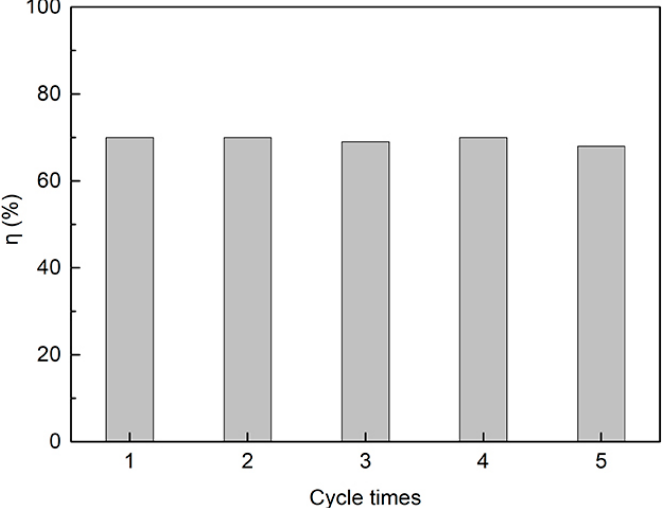
Figure 12. The reusability of the g-C 3 N 4 / Fe 3 O 4